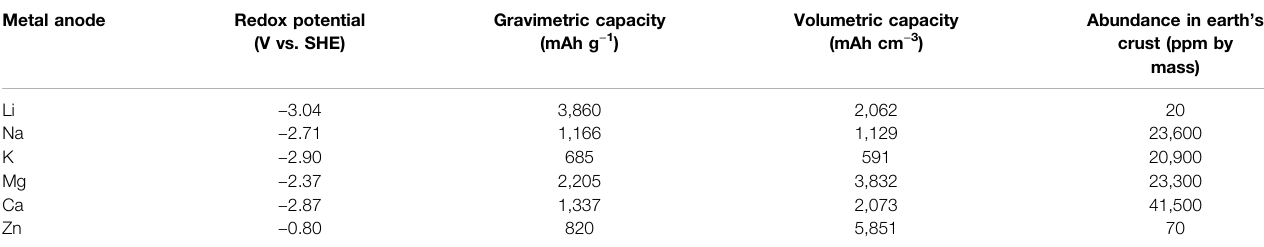
TABLE 2 | Theoretical capacities (gravimetric and volumetric), redox potentials under standard aqueous conditions, and abundance of various metal anodes. Abundance values are taken from reference (Haynes, 2014). Metal anode Redox potential (V vs.